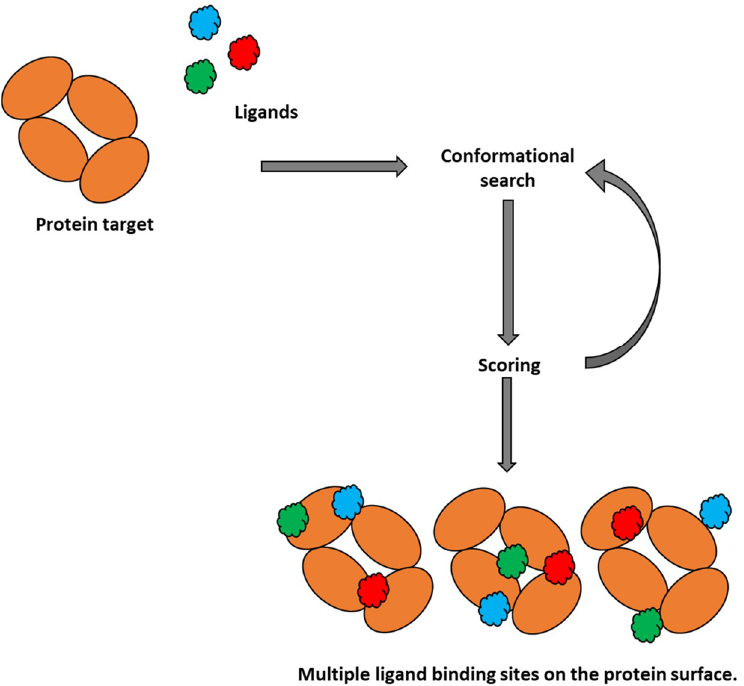
Figure 2. A schematic of the molecular docking process on a single multimeric protein.